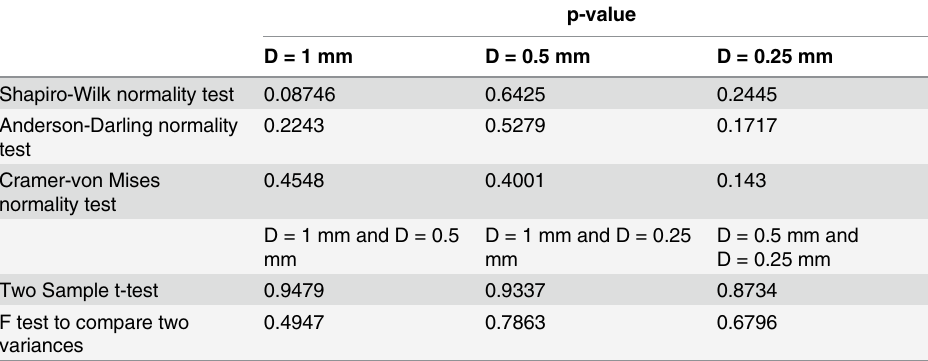
Table 5. Statistical analysis of shear stress